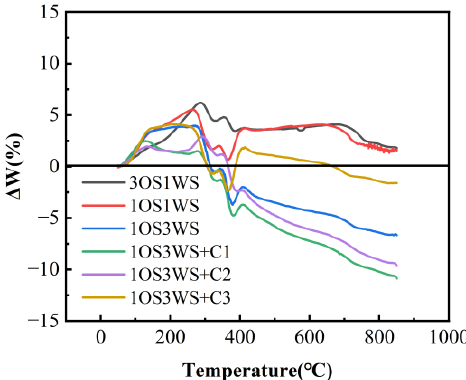
Figure 6. Variation of Δ W for the mixtures.